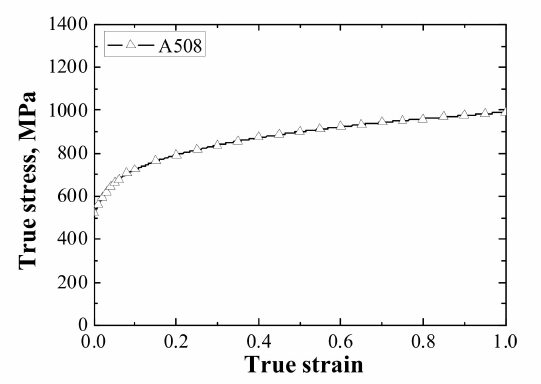
Figure 1. The true stress versus strain curve of the ductile material A508.